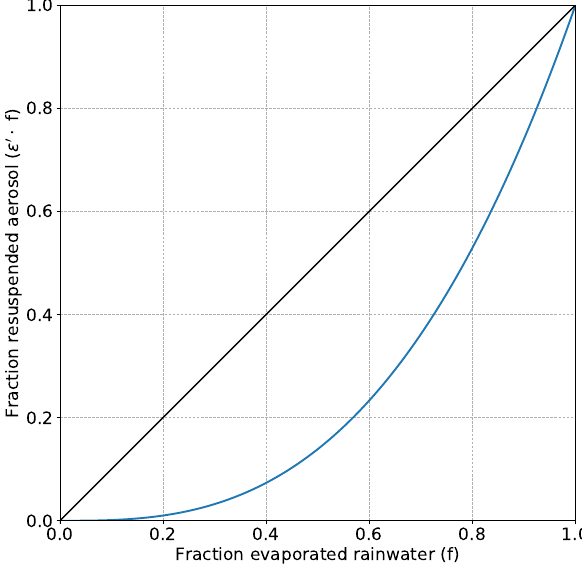
Figure 2. Relation between fraction of evaporated rainwater f and the fraction resuspended aerosol (cid:15) (cid:48) · f